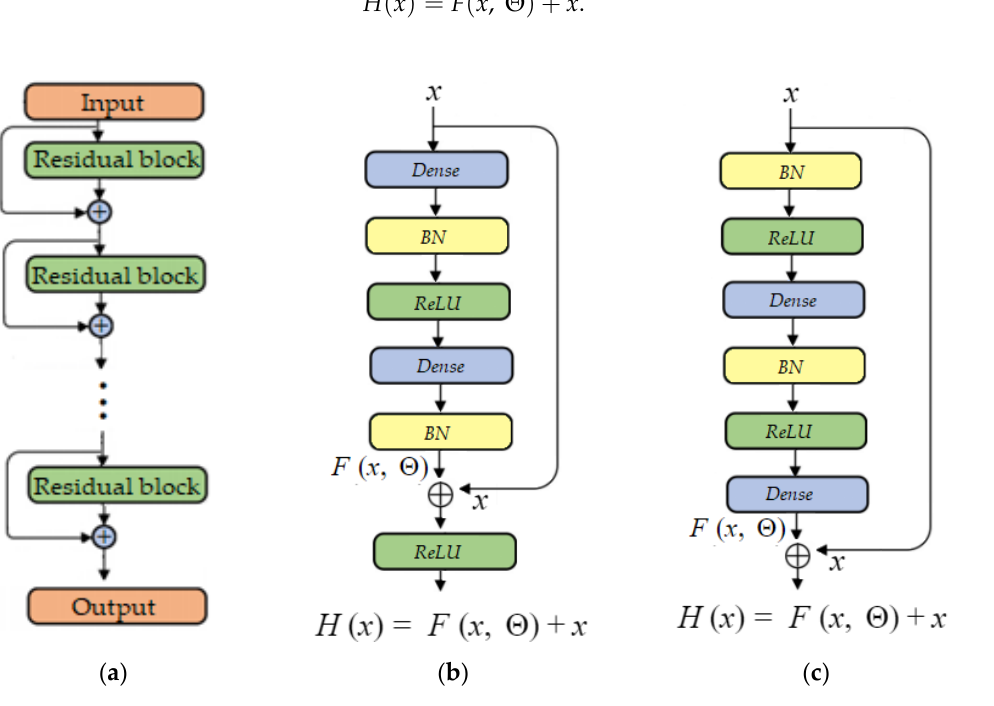
Figure 6. ( a ) Deep residual neural network (DRNN) structure; ( b ) original residual block; ( c ) pre-activation variant of residual block.